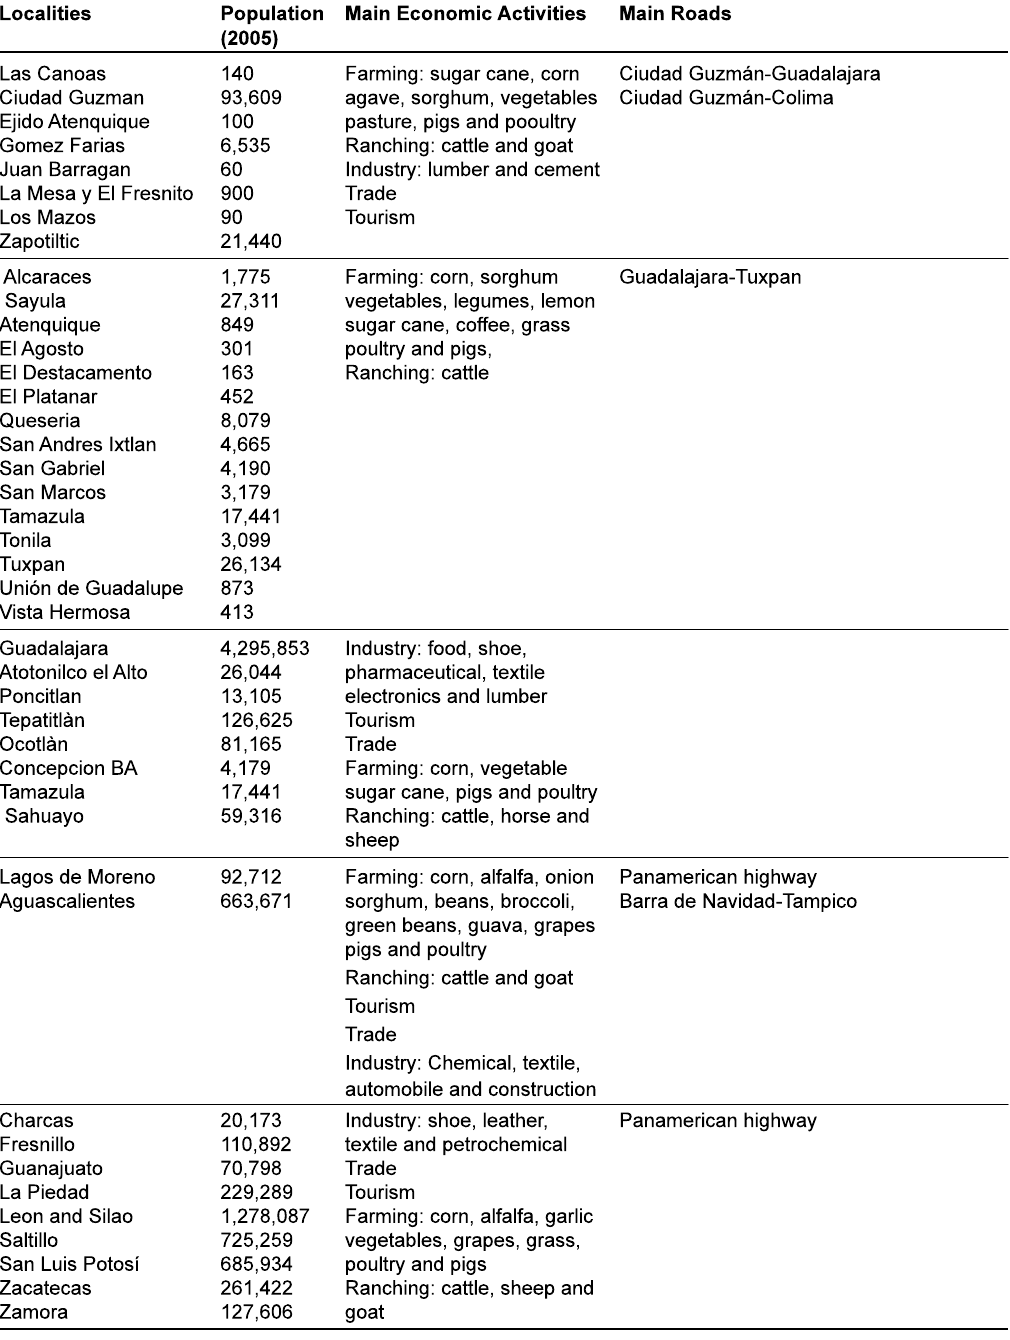
! Table 7. Scenario 3. Localities, populations, main economic activities and roads which would be affected by different ash-fall levels during an eruption occurring in May (north-northeast level IV